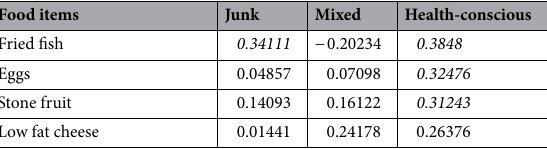
Table 3. Principal component loadings with 57 food items and varimax rotation (n = 325). Loadings ≥ 0.3 in italics.